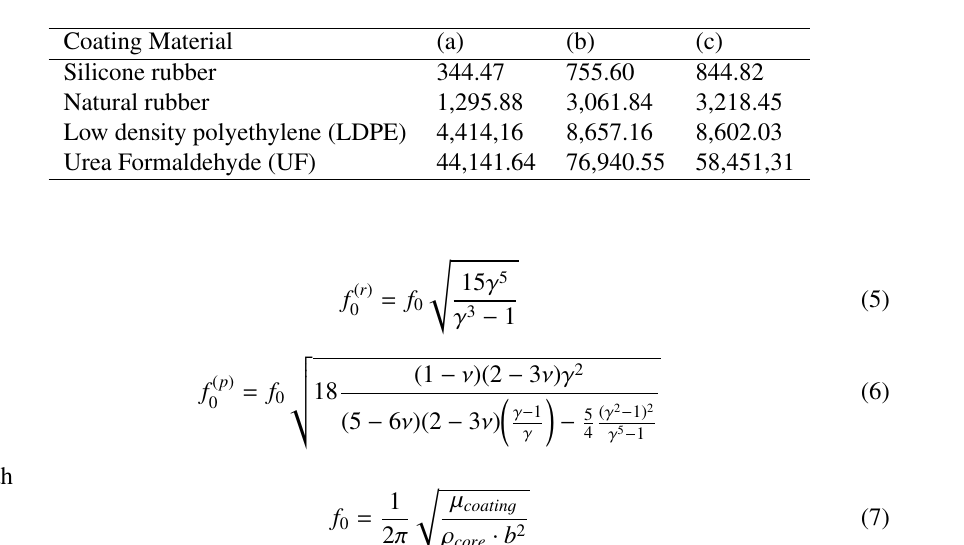
Table 2. Translational natural frequency [Hz] for each aggregate configuration computed using (a) one-dimensional spring-mass model, (b) closed form solution derived from a value elasticity problem, and (c) finite element